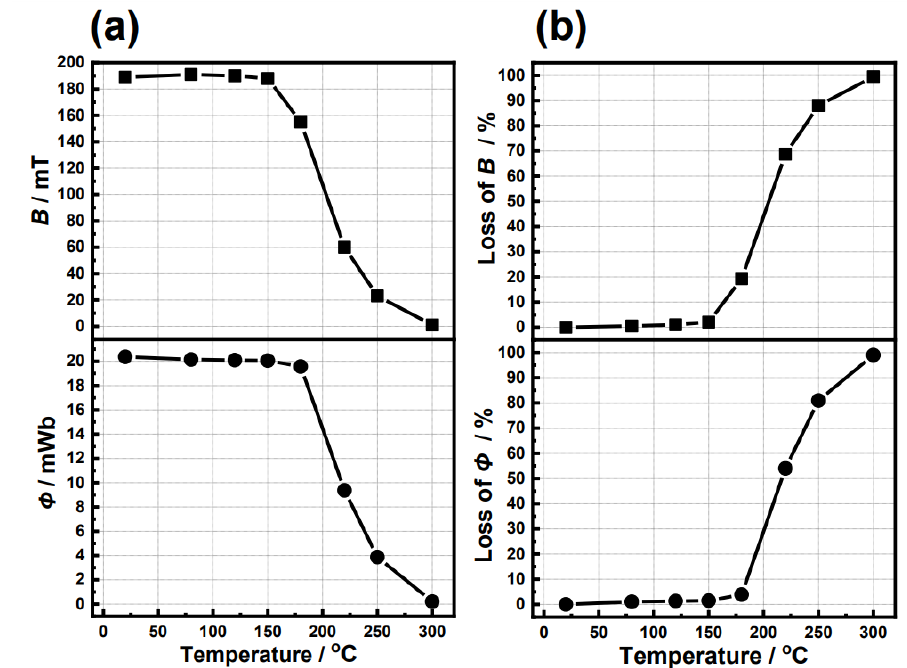
Figure 1. Temperature dependence of ( a ) Φ , ( b ) B and their losses of the samples from R.T. to 300 °C.